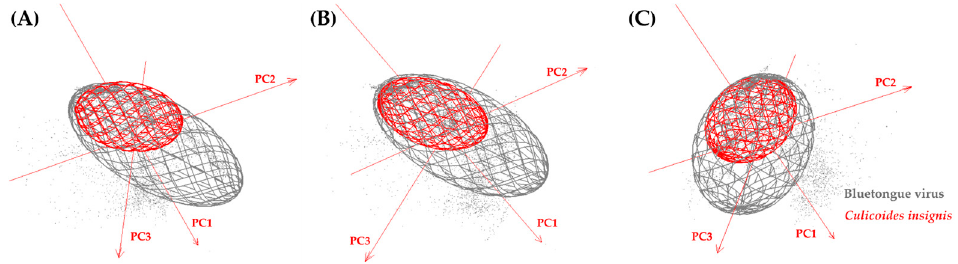
Figure 6. Minimum-volume ellipsoid (MVE) niche estimations for bluetongue virus and Culicoides insignis in three-dimensional environmental space in Peru based on the current ( A ) and future climate in two distinct scenarios: ( B ) SSP126 and ( C ) SSP585. Gray points represent environmental background conditions.